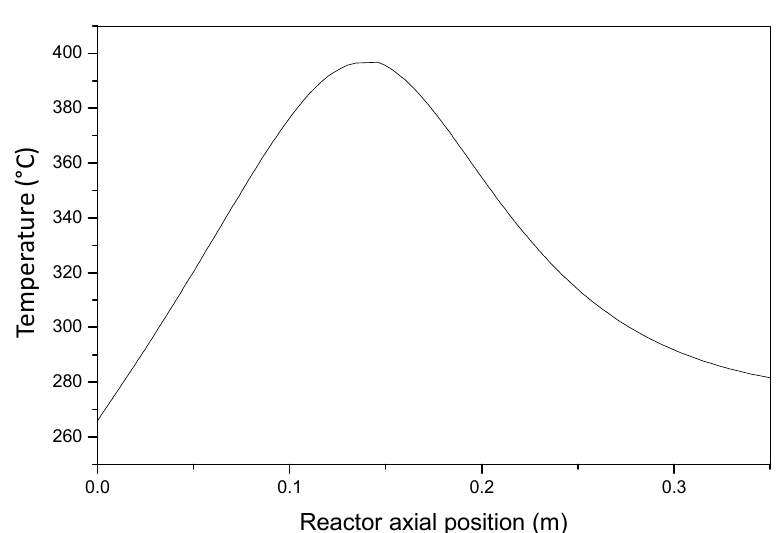
Figure 17. Axial profiles for component mole fractions.